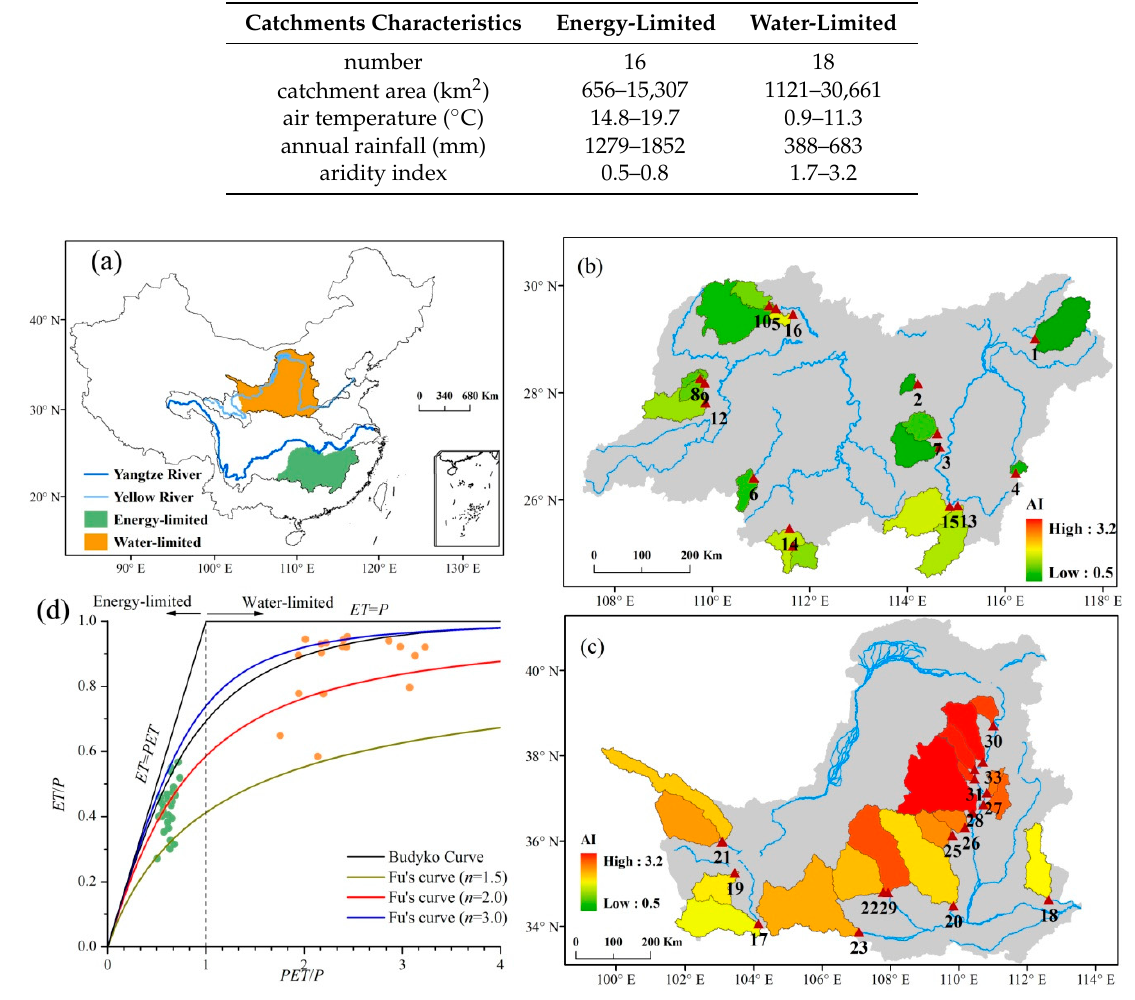
Figure 1. ( a ) Sketch map of the study area, ( b ) catchments under energy-limited condition, ( c ) catchments under water-limited condition, and ( d ) the long-term hydroclimatological characteristics of the 34 selected catchments based on the Budyko hypothesis. AI is the aridity index, P is precipitation, PET is potential evapotranspiration and ET is actual evaporation. Triangle in ( b , c ) represents the location of hydrological station.